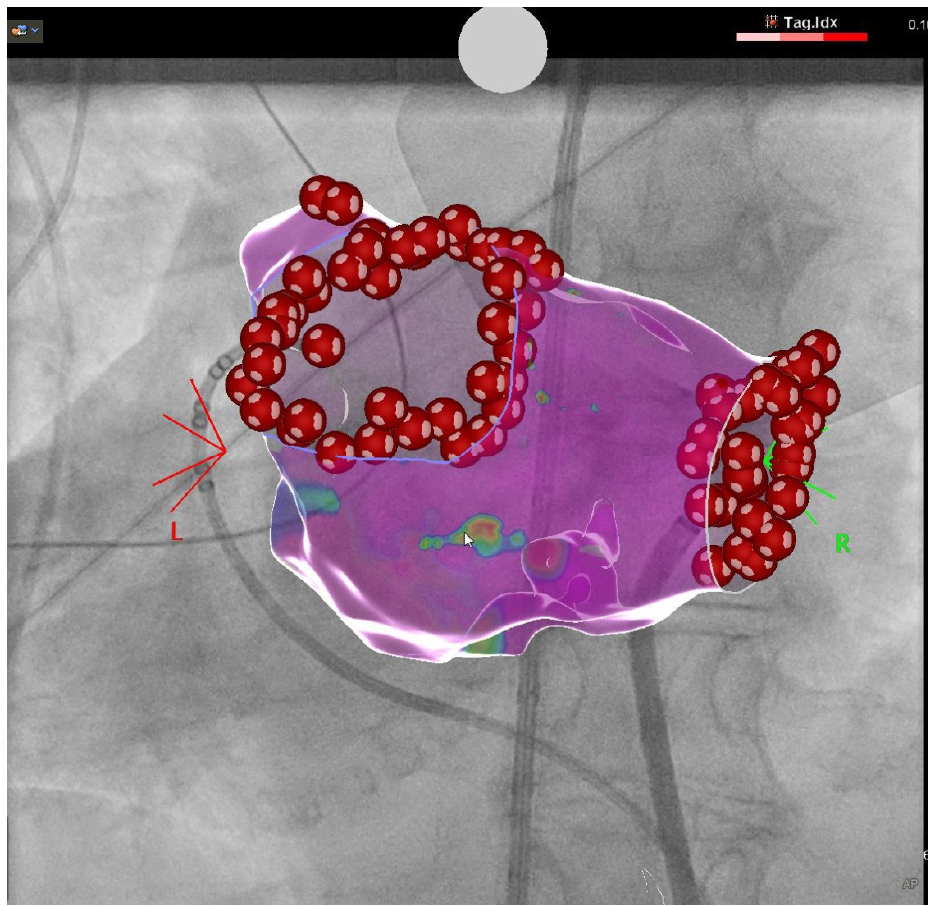
Figure 1. Electroanatomical reconstruction of a left atrium utilizing a 3D mapping system. PA view.